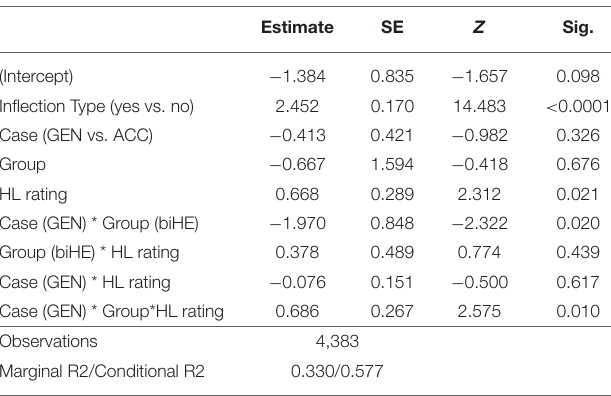
TABLE 7 | Model summary for target case production (cross-linguistic influence and language-external variables). Estimate SE Z Sig.